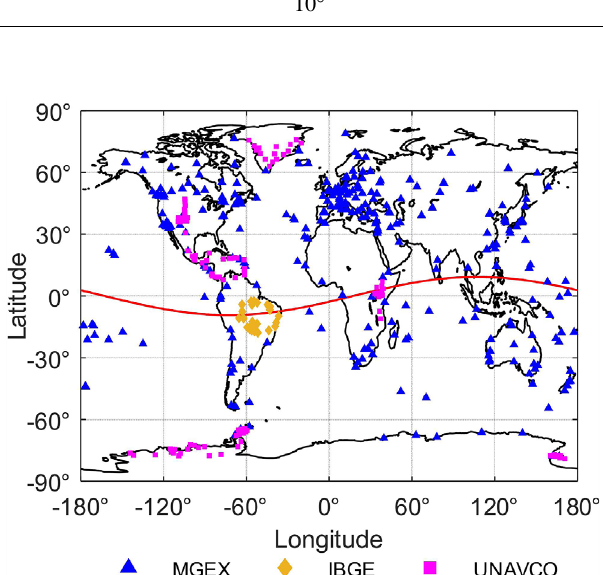
Figure 1. Distribution of GNSS stations used in this study. The blue triangle in the fi gure represents the IGS MGEX stations, the yellow diamond represents the IBGE stations, and the magenta square represents the UNAVCO stations. The solid red line represents the magnetic